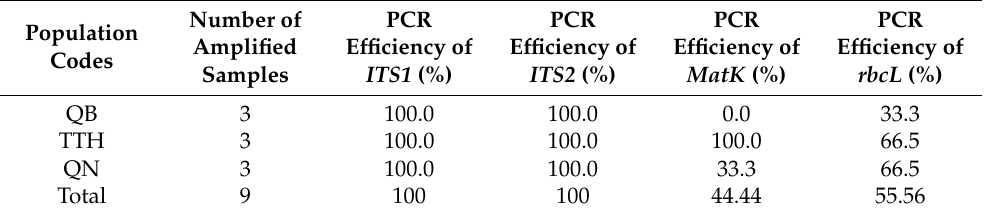
Table 2. Efficiency of PCR amplification of four potential barcodes in three populations of M. officinalis